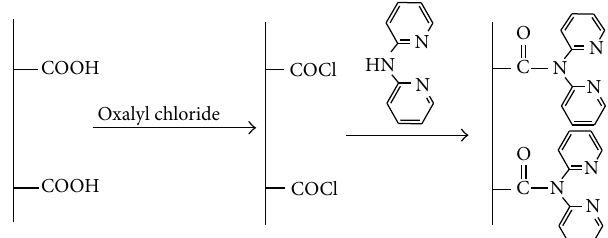
F 1: A schematic diagram for modi�cation of MWCNT with dipyridile